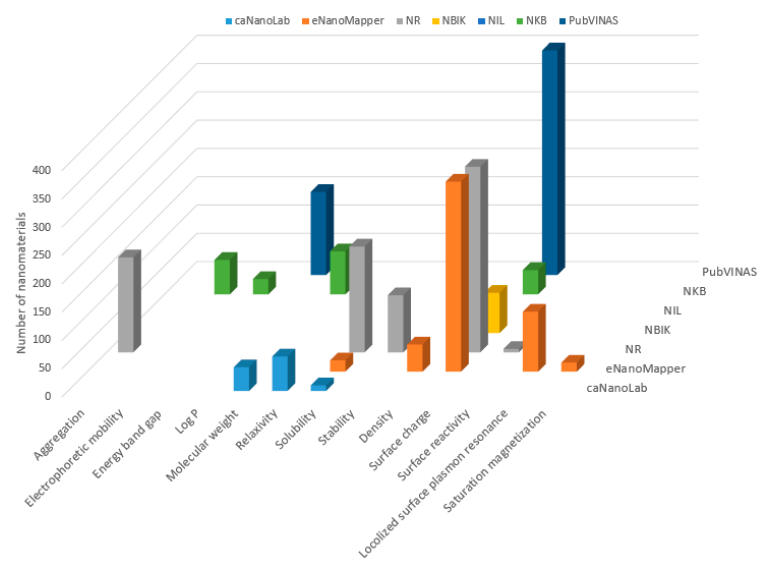
Figure 4. Number of nanomaterials ( z -axis) with physicochemical properties (indicated on the x -axis) in the seven databases (depicted in different colors and marked on the y -axis).